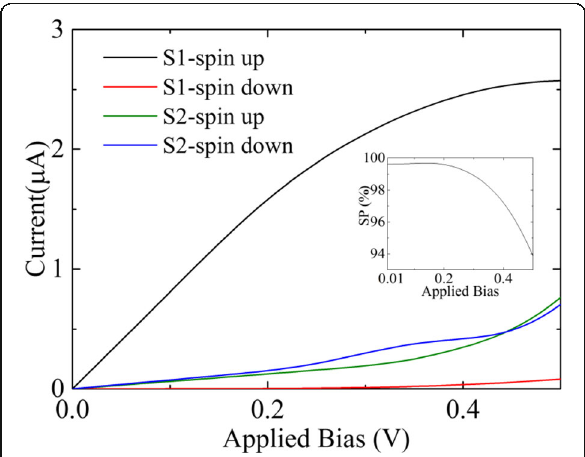
Fig. 4 The spin-resolved current voltage characteristics of the device at [1,1] configuration. The inset shows the spin polarization of structure